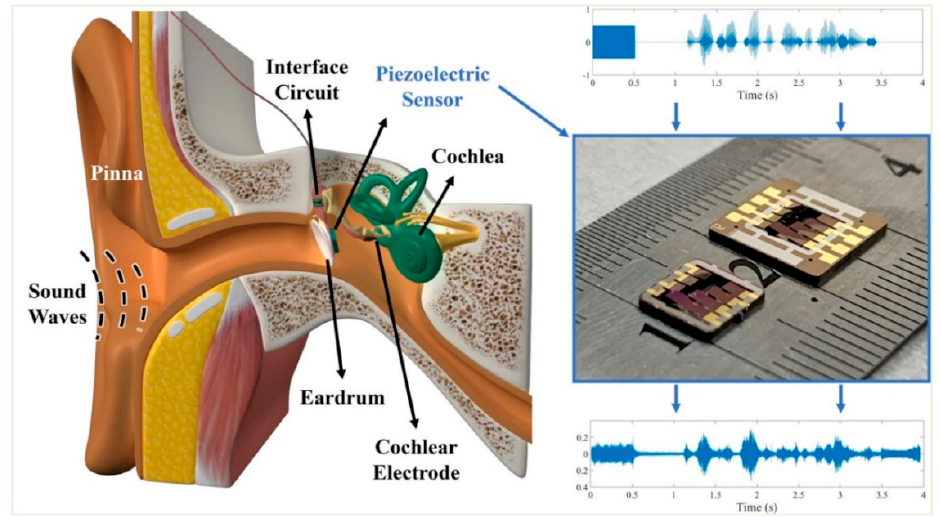
Figure 7. Piezoelectric MEMS sensor to feed cochlear electrodes. Open Access [65] © 2022 IEEE.